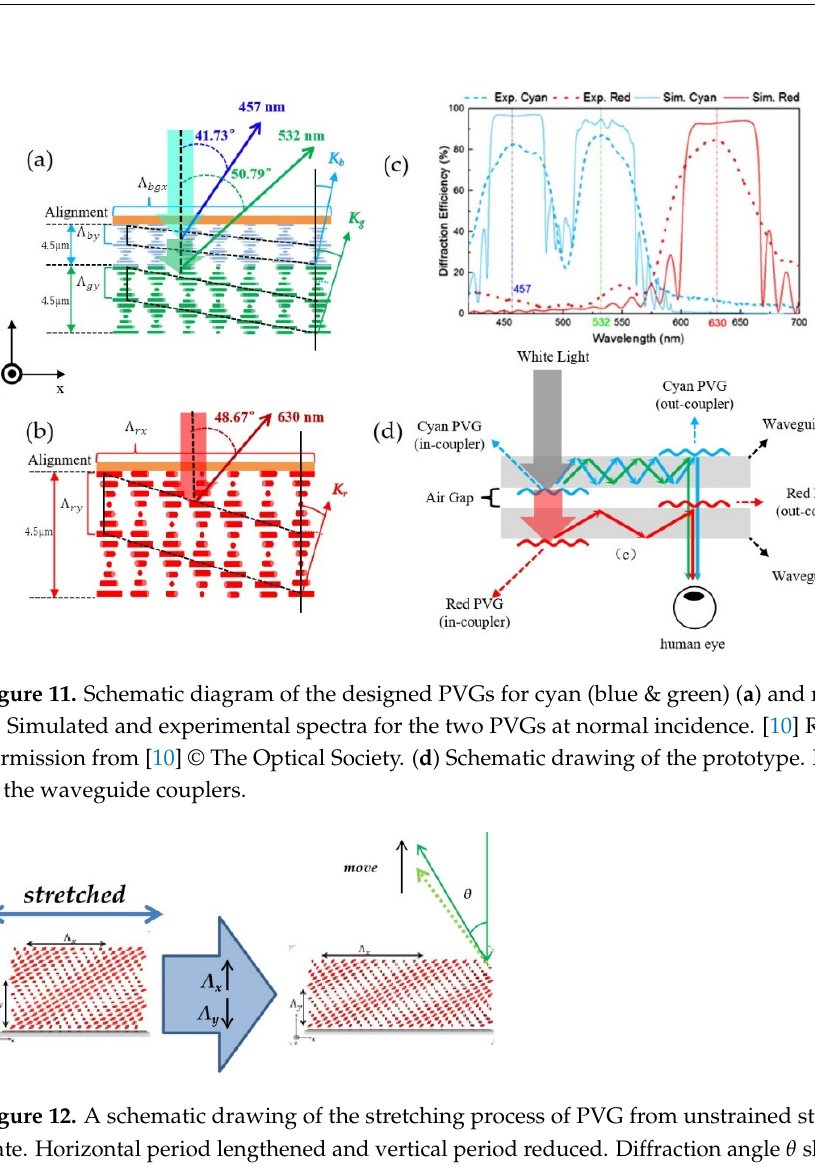
Figure 12. A schematic drawing of the stretching process of PVG from unstrained state to strained state. Horizontal period lengthened and vertical period reduced. Diffraction angle θ shift (@ 532 nm) under different stretched lengths.